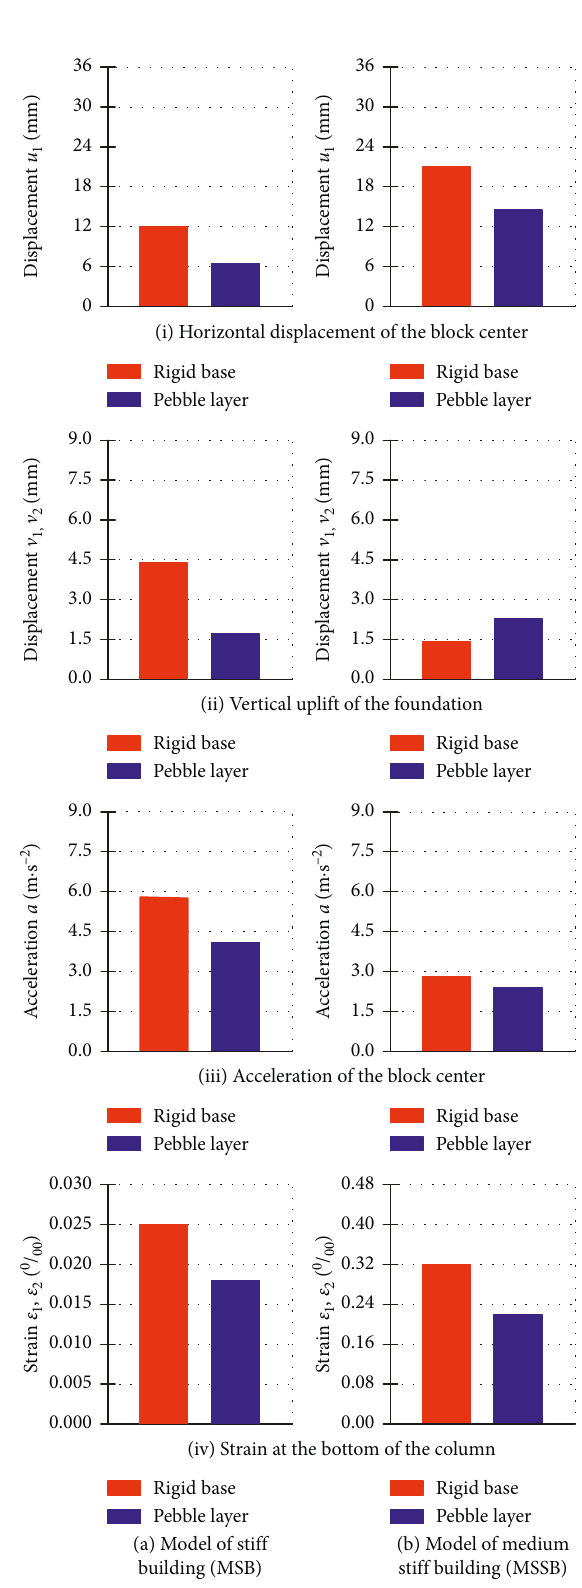
Figure 22: Some maximum measured values for the accelerogram Ston (AA). (a) Model of stiff building (MSB). (b) Model of medium stiff building (MSSB).